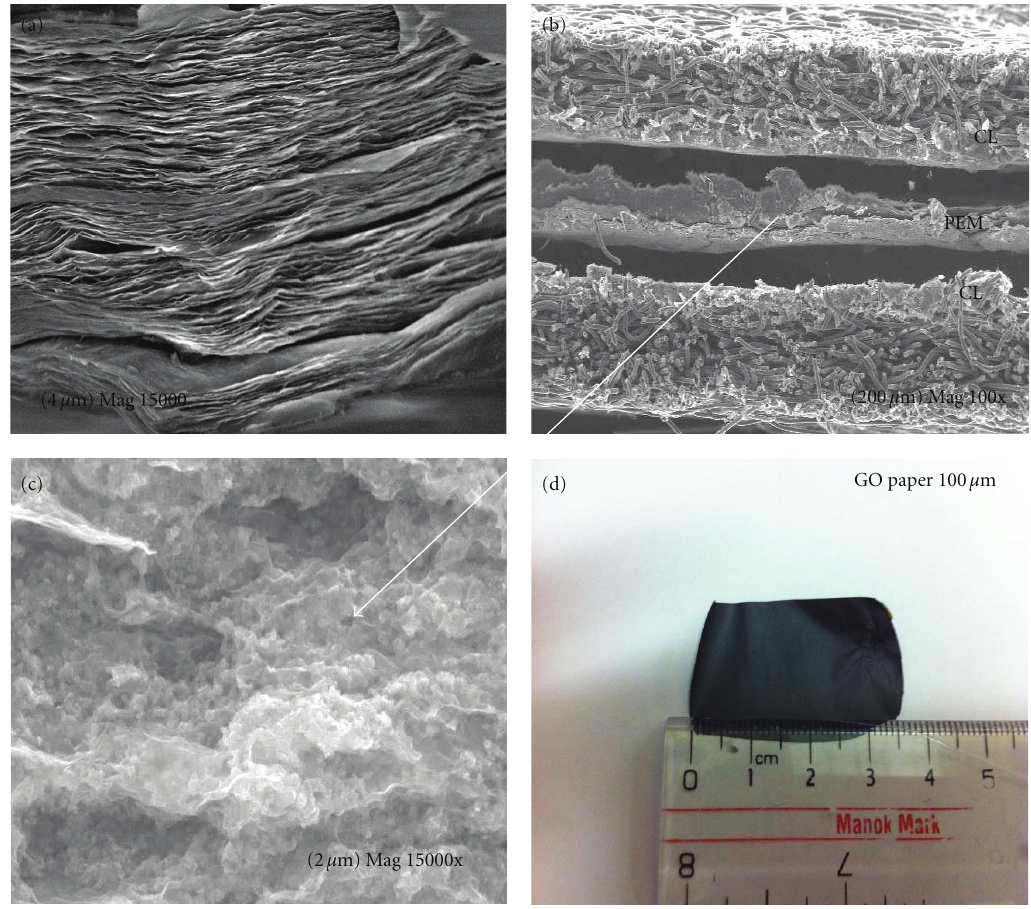
Figure 3: SEM images of Graphite oxide paper and MEAs made with GO paper. (a) Cross section of GO paper, (b) cross section of GO paper within the MEA, (c) cross section of GO paper in the MEA, and (d) picture of GO paper.